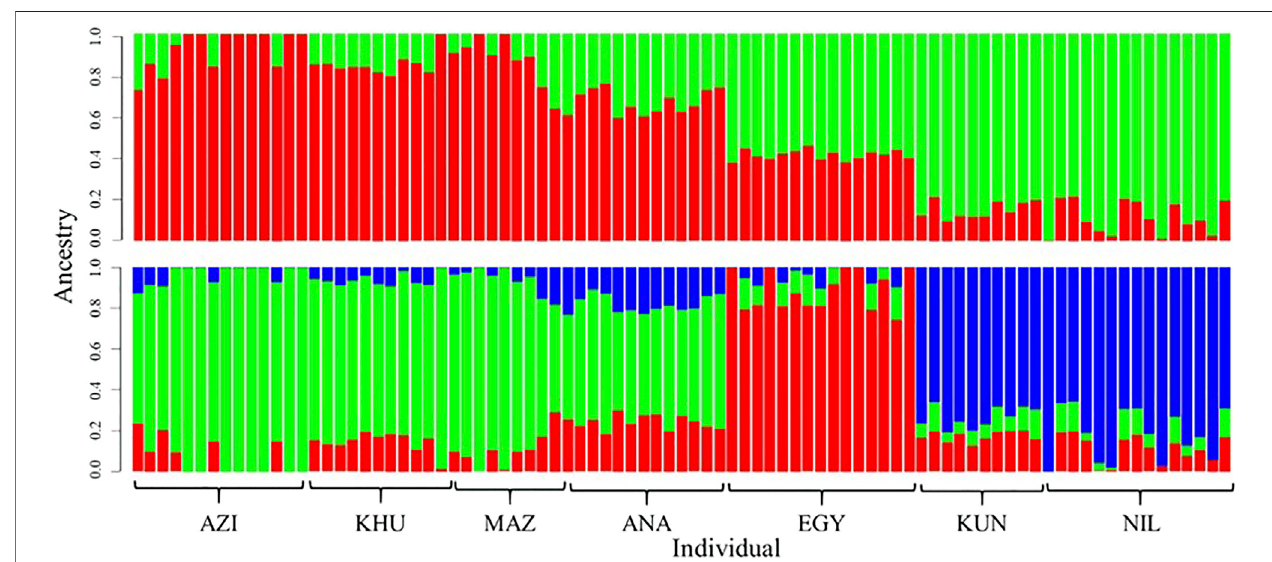
FIGURE2| Genetic compositionofbuffalobreeds revealed withADMIXTURE software at K (cid:1) 2 (top) and K (cid:1) 3 (bottom) . Individuals are represented with vertical colored bars. Genomic components are assigned different colors.